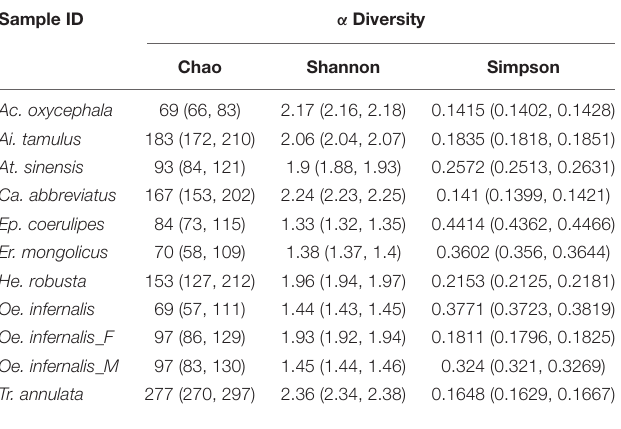
TABLE 1 | Diversity Index of Gut Bacteria in Each